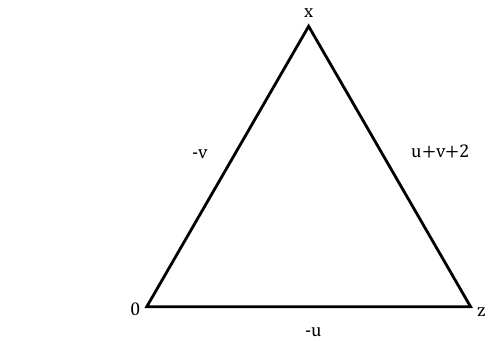
and x are the i j